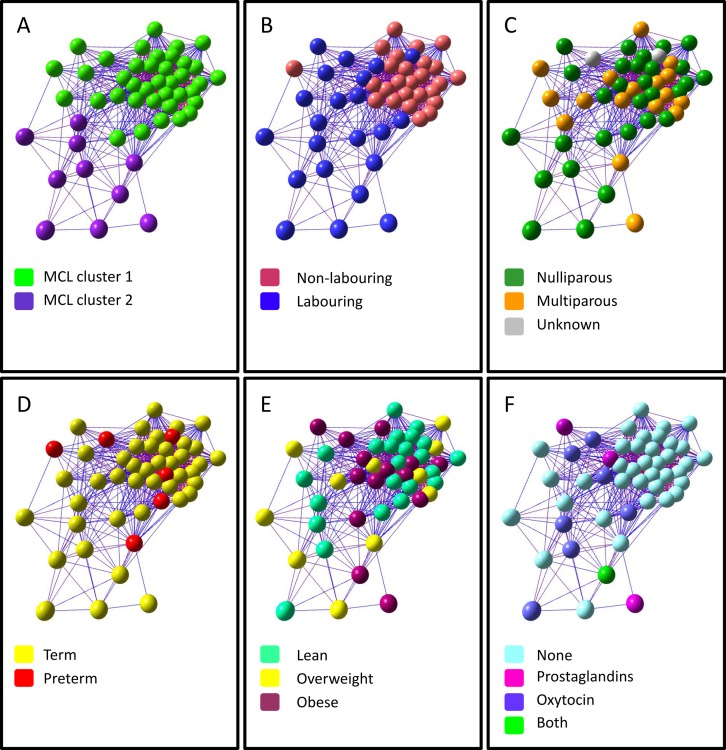
Sample-sample network graph, in which each node represents a different sample.Edges are coloured to reflect the Pearson correlation that they represent. Red edges represent a high correlation and blue edges represent a low correlation. The same graph is coloured by A. unbiased MCL cluster number, B. labour status, C. parity, D. gestational age at delivery, E. body mass index (BMI), and F. pharmaceutical treatment.